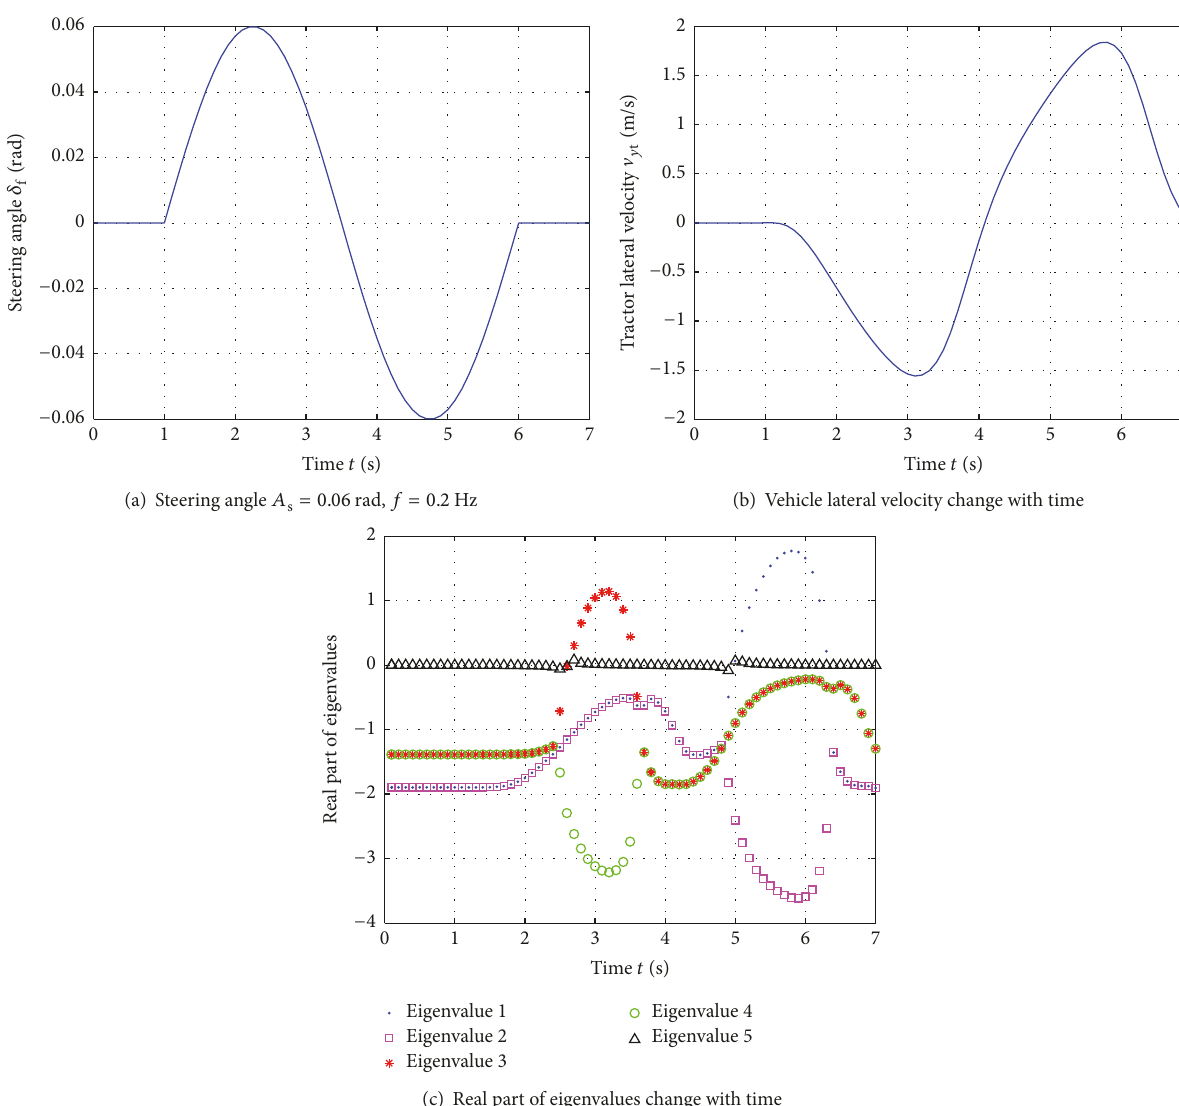
= 0.06 rad, 𝑓 = 0.2 s